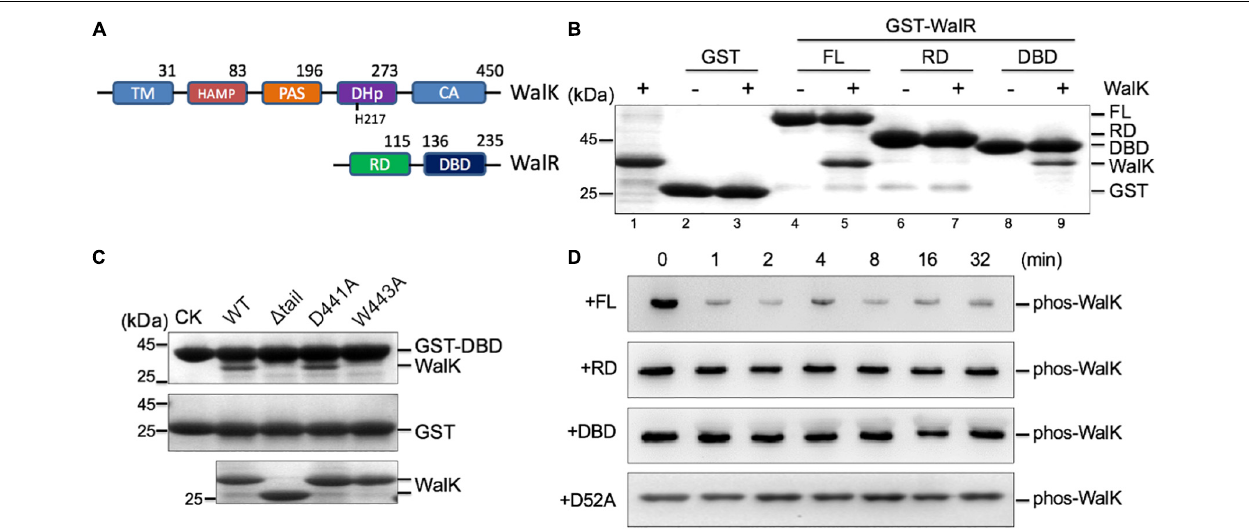
FIGURE 3 | The CTT of S. mutans WalK contributes to the interaction with the WalR DBD. (A) The domain architectures of WalK and WalR. (B) WalK (196–450) interacts with WalR in GST pull-down experiments. The 10% loading controls for WalK, GST, GST-WalR full-length (FL), GST-RD, and GST-DBD are shown in lanes 1, 2, 4, 6, and 8, respectively. (C) Mutations in the WalK CTT disrupt the interaction with the WalR DBD. As a negative control, GST alone was used to pull down WalK (middle gel). Shown in the bottom gel are 10% of the WalK protein used above. CK shows GST-DBD or GST used in the pull-down. (D) Phosphotransferase activity of WalK is diminished toward the RD of WalR alone. Phosphorylated WalK detected by anti-thiophosphate antibody was incubated with WalR full-length, RD, DBD, and D52A, shown from top to bottom, respectively.